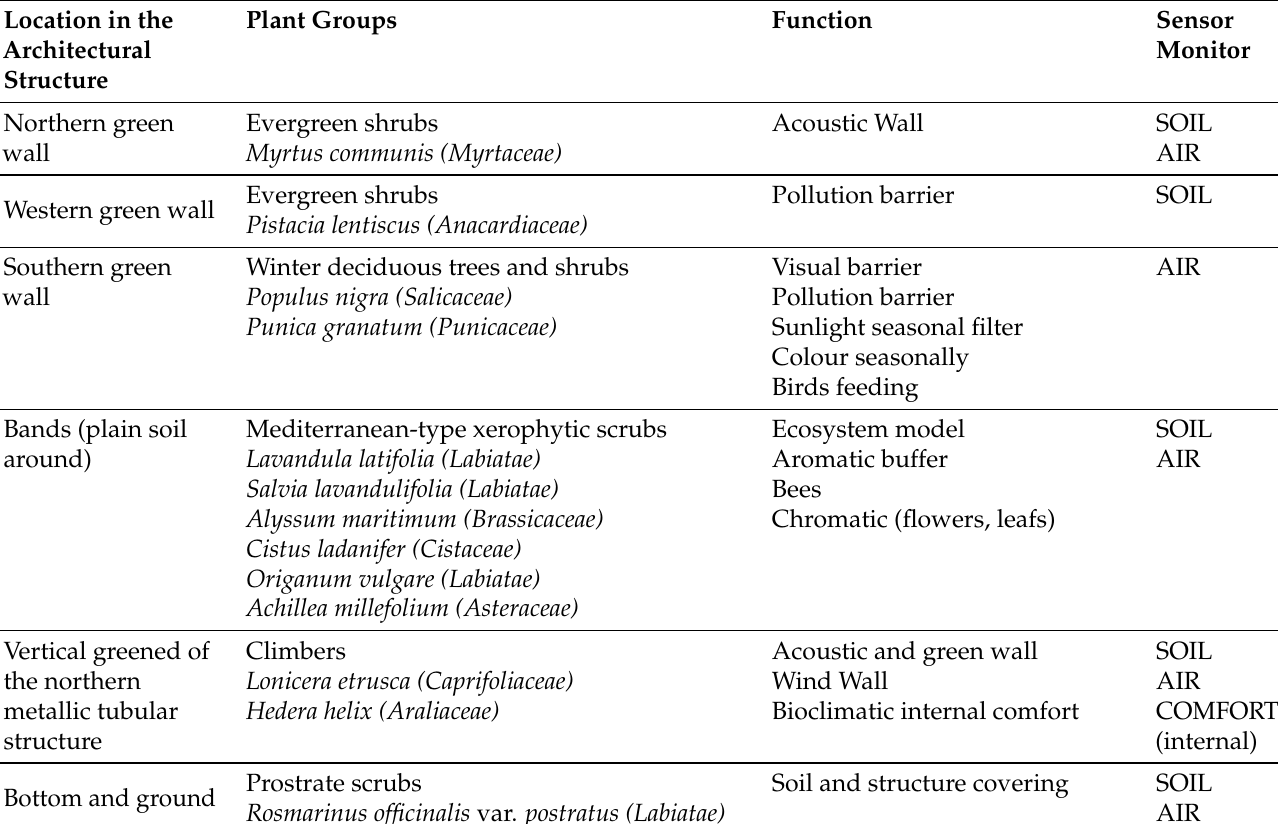
Figure 13. Diagram of ICT elements positioning. Sensing nodes (green), central nodes (blue) and electricity supply connection (yellow). Table 2. Selection of plant functional groups: species, environmental function, location in the Smart Tree architectural structure or surrounding enclosure and monitoring of the plants by sensoring